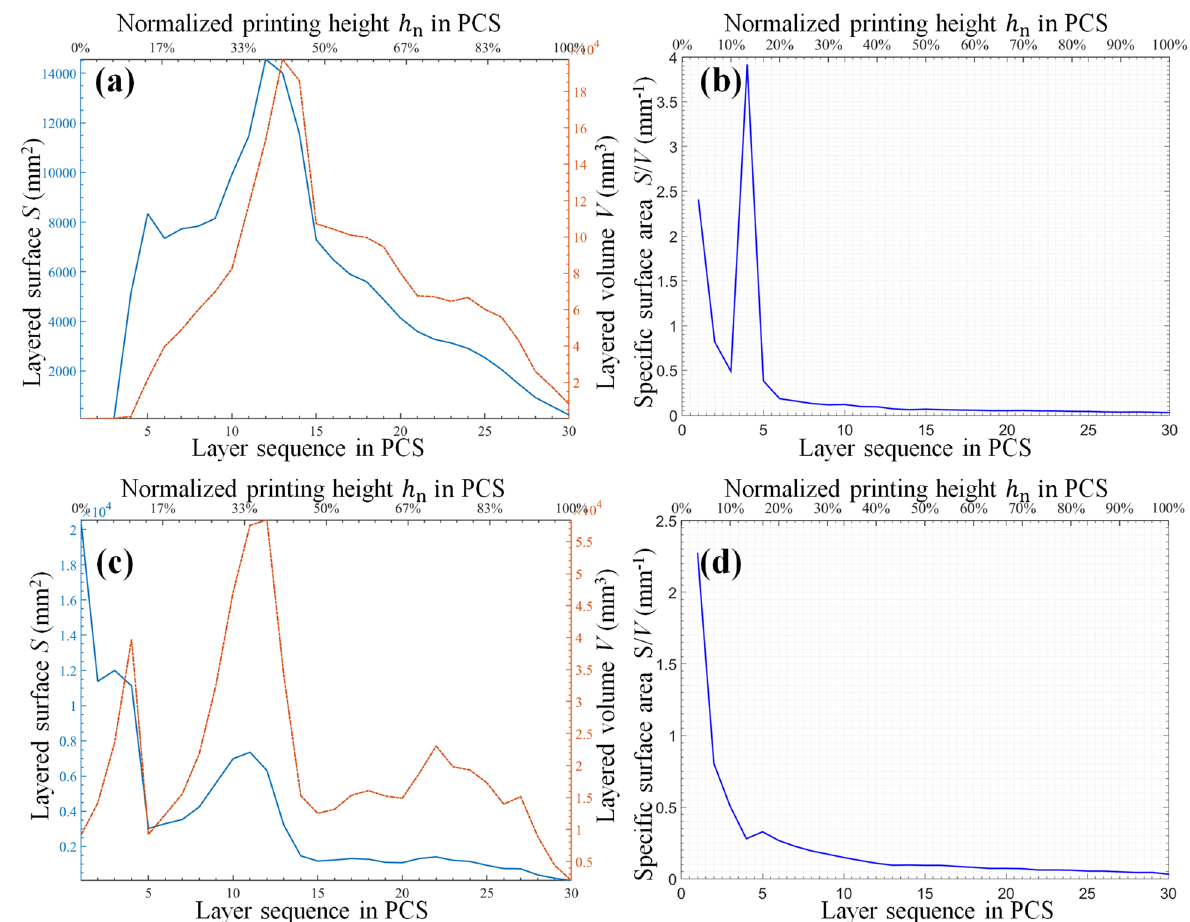
Fig. 8 Layered surface and volume along with specific surface area of the functional half handle: a and b represent the original manifold, whereas c and d represent the external